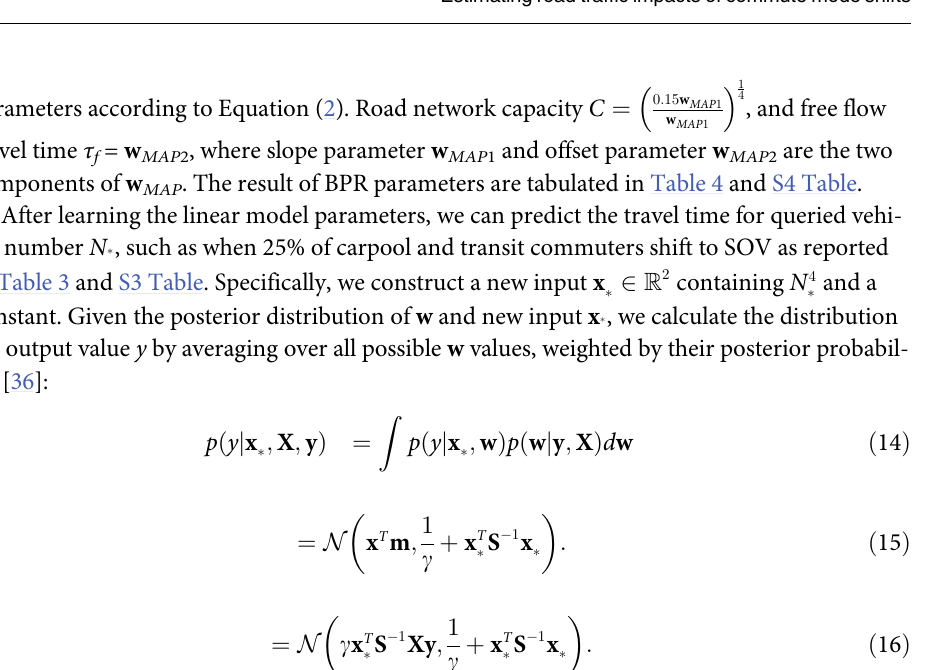
S2 Table. Summary of BPR models for all 74 analysed metro areas. Years of data available for fitting the model and performance measures for the fitted model. S3 Table. Summary of city transportation status in 2018 and prediction if one in four com- muters switch from transit or car share mode to SOV mode. All 74 analysed cites are shown, ranked by total cost per day. The range shows one standard deviation of the predic- tions. M denotes millions. B denotes billions. The major city is listed here in representation of the metro